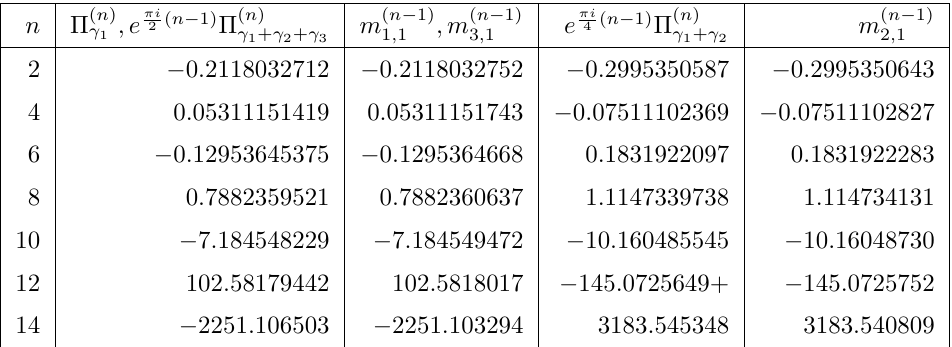
Table 2. Π ( n ) γ and m ( n − 1) for the fourth order ODE with p ( x ) = x 2 − 1 a, 1